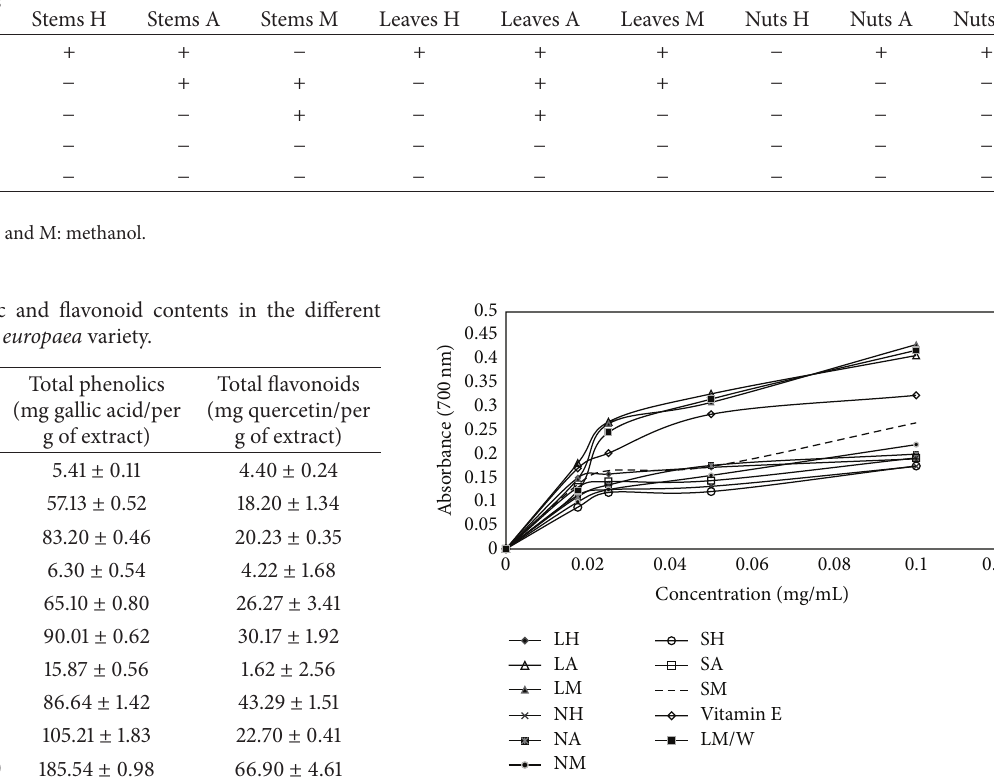
than Vitamin E and BHT used as a reference. This activity would be due to the high content of phenolic compounds in methanol and methanol/water extracts from leaves of chetoui O. europaea variety especially oleuropein and hydroxyty- rosol. The chemical activities of polyphenols in terms of their reducing properties as hydrogen or electron-donating agents redirect their potential for action as free-radical scavengers (antioxidants). Polyphenols possess ideal chemical structure for free radical-scavenging activities and most of them have been shown to be more effective antioxidants in vitro